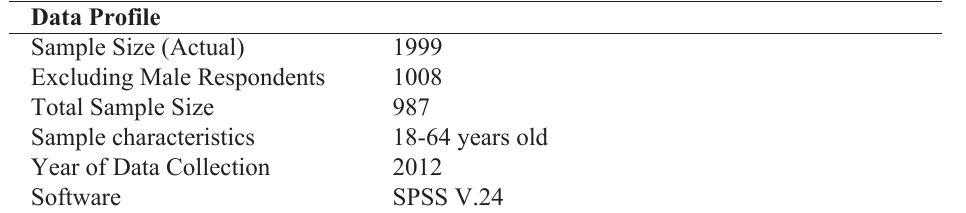
Table 01: Sample